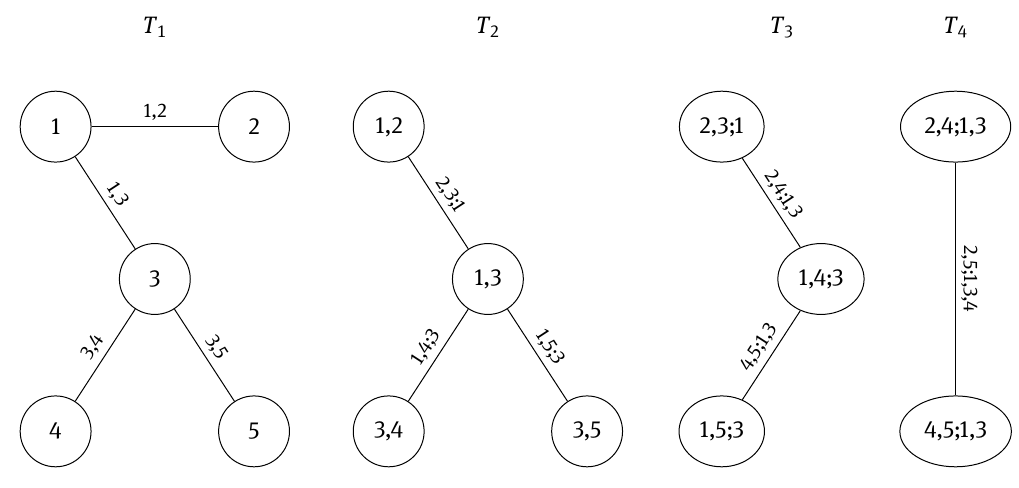
Figure 1: Example of a regular vine tree